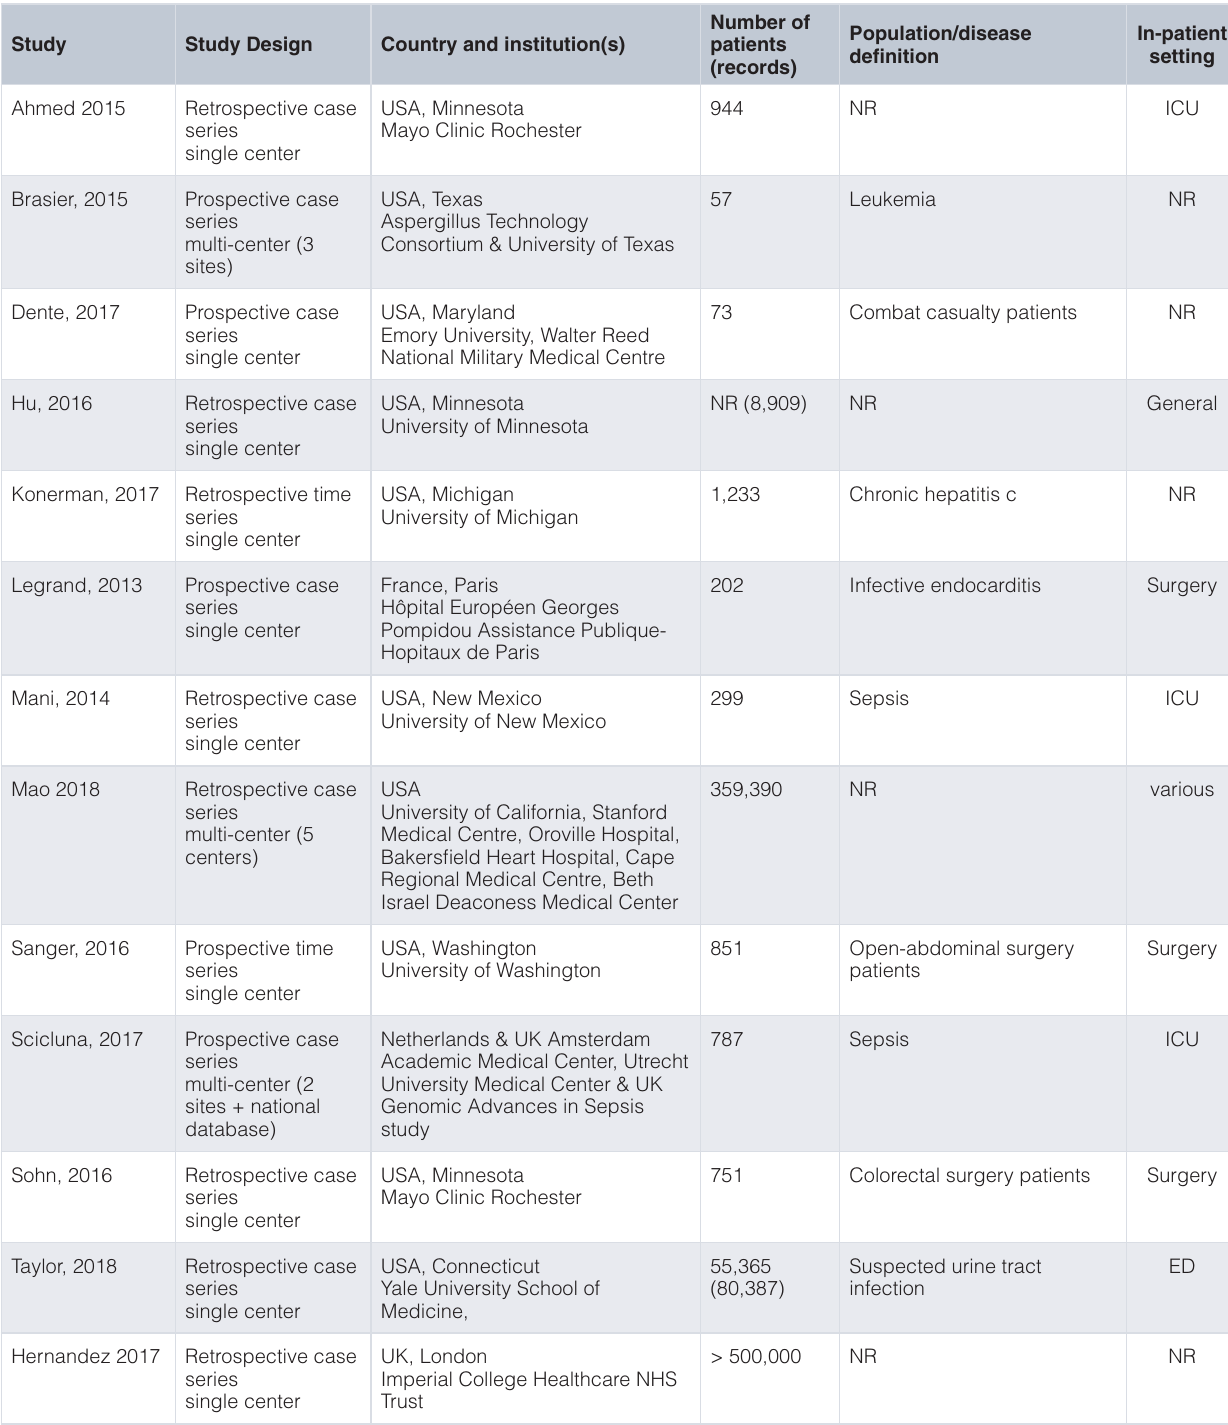
Table 9. Design aspects of published studies on infection or